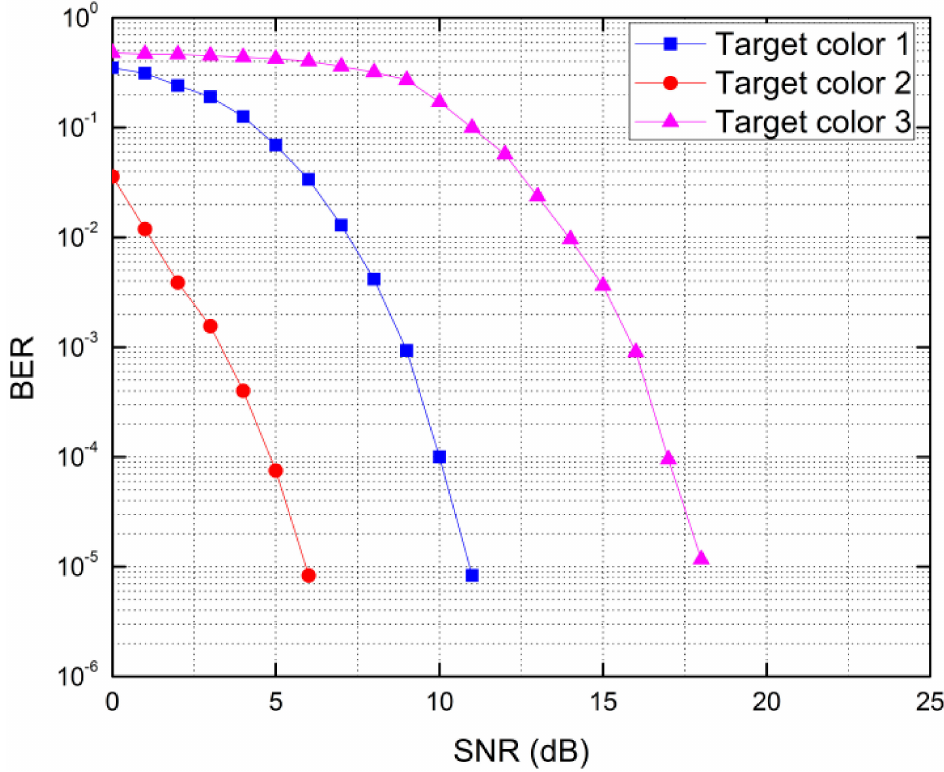
Figure 8. Comparison of BER vs. SNR for three target colors